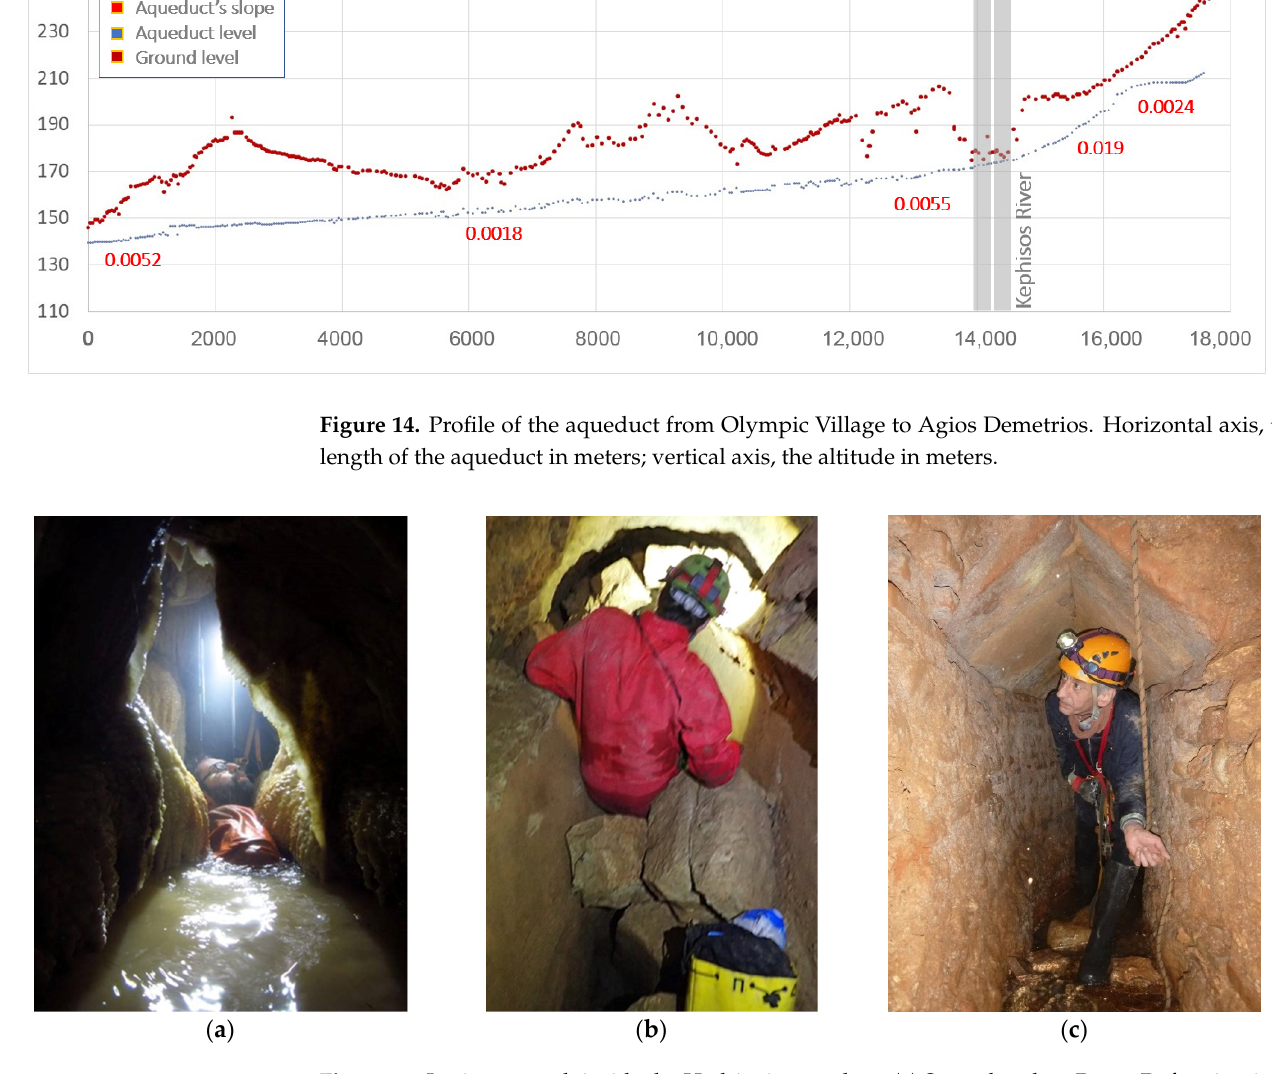
Figure 15. In situ research inside the Hadrianic aqueduct. ( a ) Second author, Panos Defteraios, in an operative and narrow part of the tunnel. ( b ) Member of the “Urban Speleology Research Team” in the tunnel of the aqueduct. ( c ) Fourth author, Prof. Nikos Mamassis, in the tunnel of the aqueduct. Table 1. Technical characteristics of the so-called Peisistratean (Hymettus) and Hadrianic aqueducts. The So-Called Peisistratean